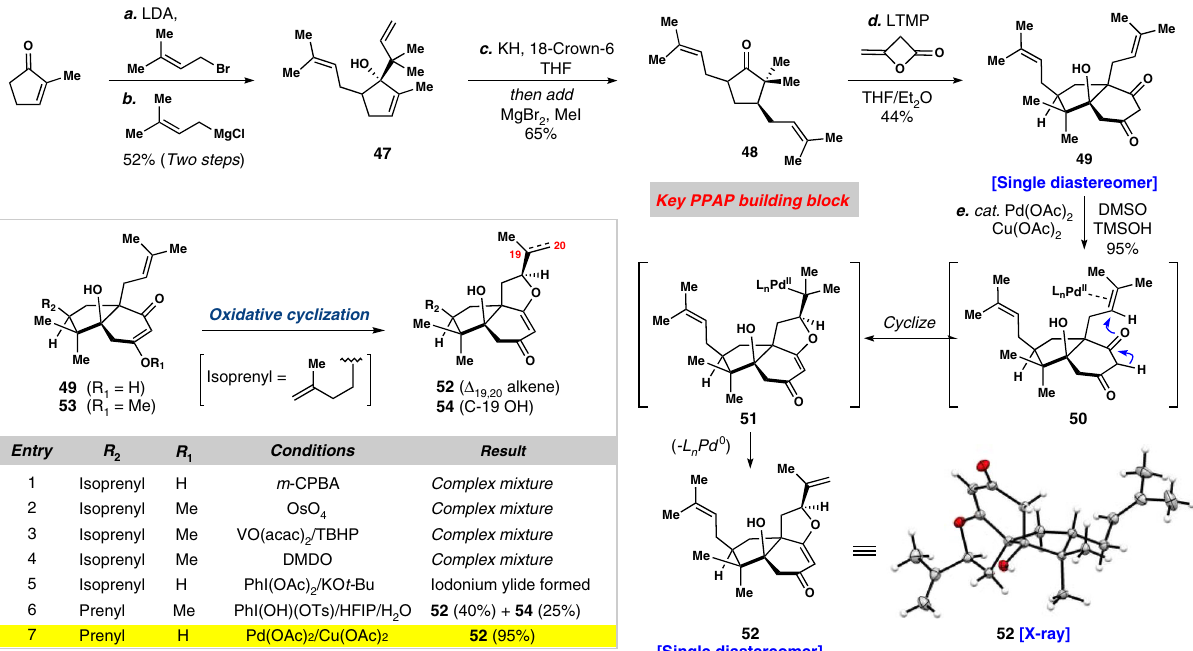
Fig. 4 Diastereoselective synthesis of a key tricyclic intermediate. A diketene annulation and unusual vinylogous acid Wacker-type cyclization forge 52 in fi ve chemical